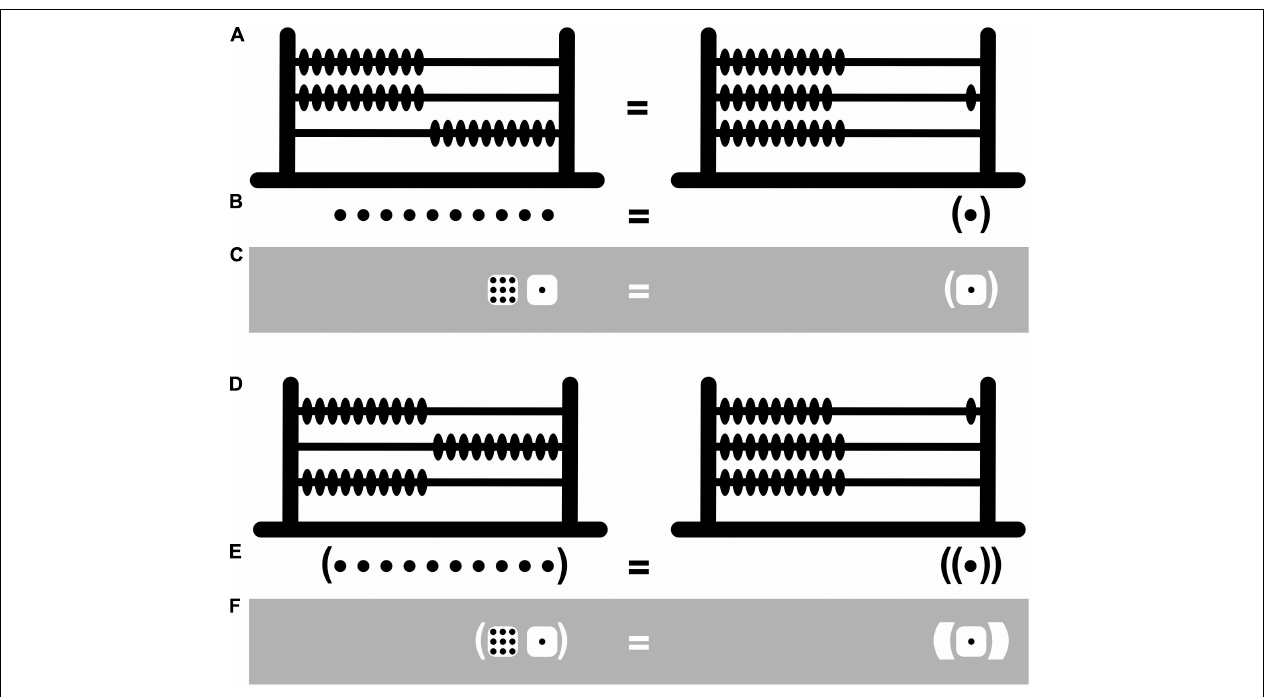
FIGURE 4 | Iconic and abacus number representation. (A) Representation of the number 10 with ten beads shifted to the right on the abacus’s lower rung (left) or, equivalently, with one bead with a value of 10 shifted to the right on its next higher rung (right). (B) A similar representation in depth-value notation with ten beads (left) or, equivalently, one bead with a value of 10 in a container (right). (C) A similar representation in black-and-white notation. (D) Representation of the number 100 with ten beads with a value of 10 shifted to the right on the abacus’s second rung (left) or, equivalently, with one bead with a value of 100 shifted to the right on its next higher rung (right). (E,F) Similar representations in the depth-value and black-and-white notations.